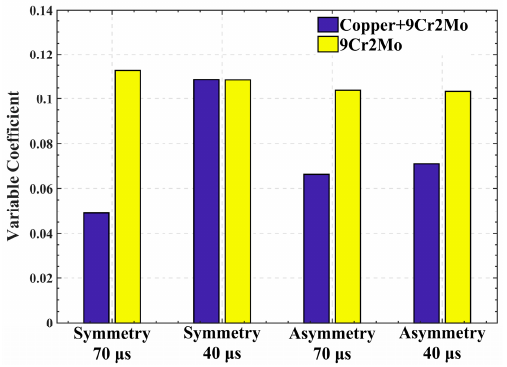
Figure 4. Variable coefficient of temperature